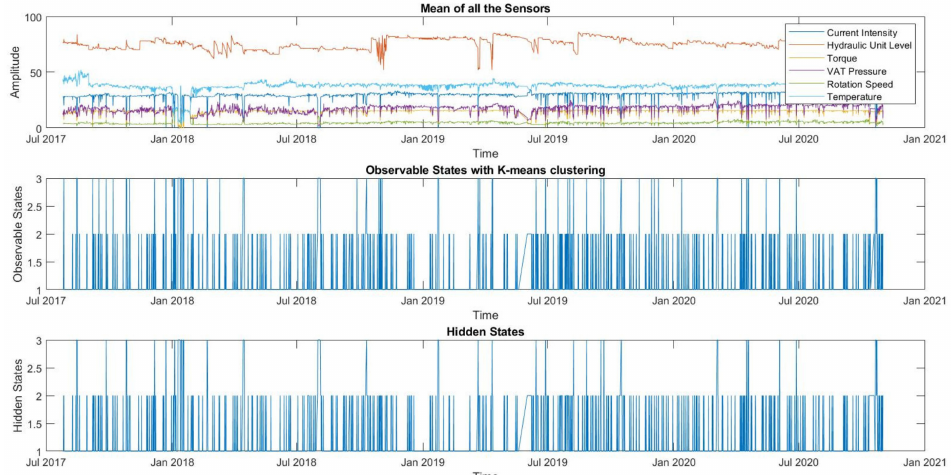
Figure 9. HMM Hidden States using the observable K-means